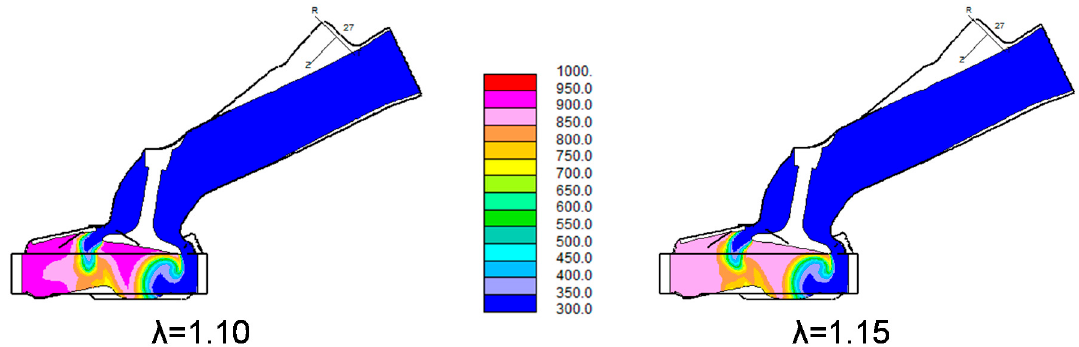
Figure 10. Simulated spatial distribution of equivalence ratios when piston and valve movements were at 40 CAD ATDC with excess air ratios of 1.1 and 1.15.